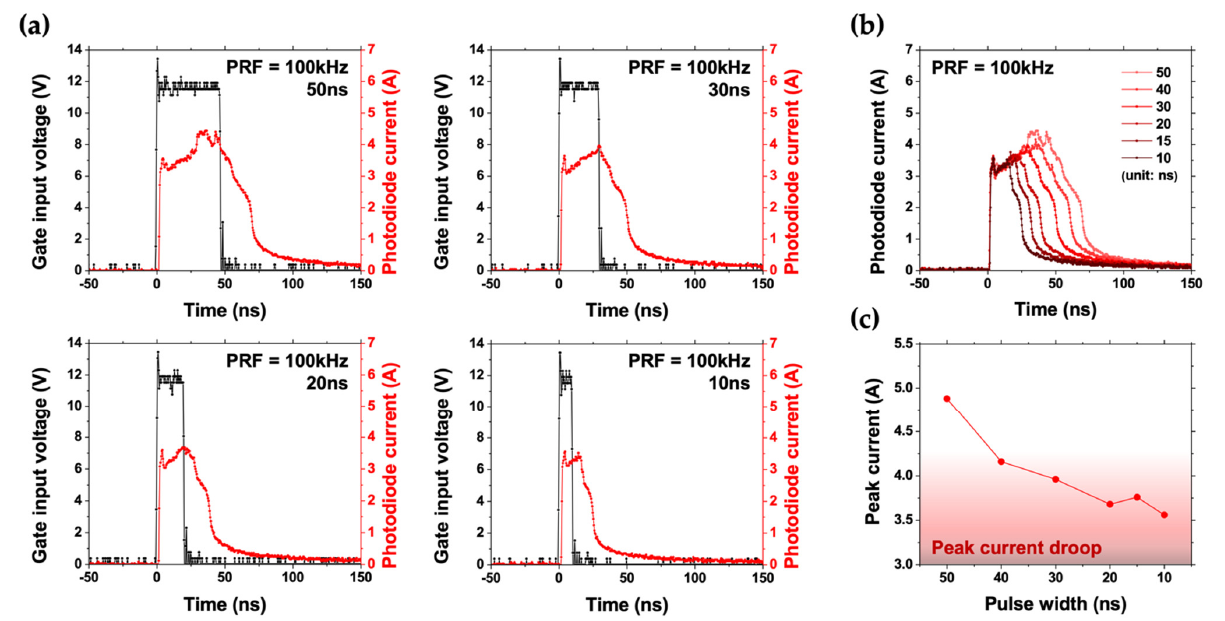
Figure 3. Characteristics of the integrated system and the corresponding photodiode responses from the employed PCSEL with a fixed pulse repetition frequency of 100 kHz. ( a ) Photodiode responses from the PCSEL with different pulse widths. ( b ) A sequence of photodiode responses from the PCSEL with various pulse widths for comparison. The shorter the pulse width, the lower the photodiode peak current. ( c ) Corresponding peak currents extracted from ( b ). Herein, the corresponding peak current drops from 4.88 A to 3.56 A with a width of 50 ns and 10 ns, respectively.